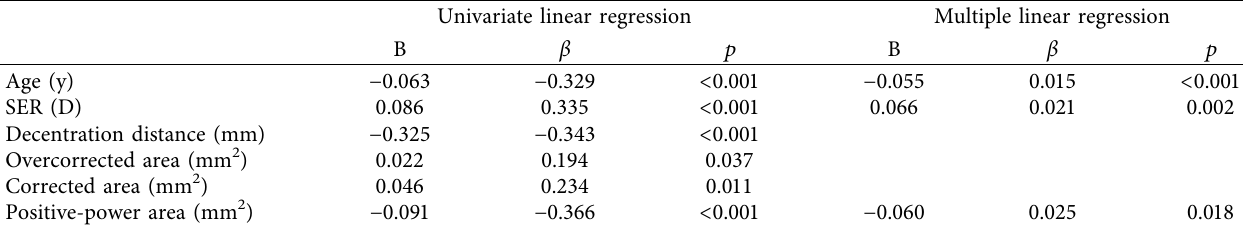
Table 2: Univariate and multiple linear regression analysis to determine the correlations between AL change and baseline age, baseline SER, decentration distance, and the different power